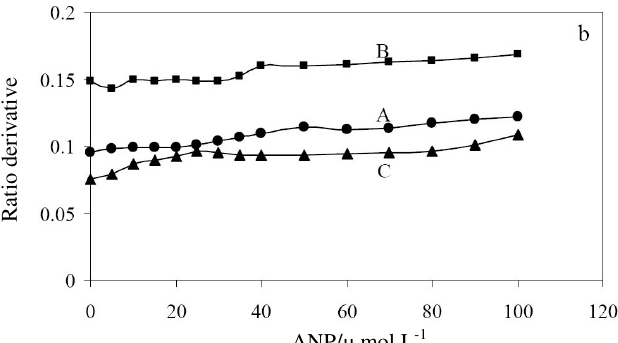
Figure 6. (a) Effect of concentrations of antazoline over the signals to analytical wavelength of 10.0 µmol L -1 naphazoline at different ∆λ values. (A) ∆λ = 2.0 nm; (B) ∆λ = 3.0 nm; (C) ∆λ = 5.0 nm. (b) Effect of concentrations of naphazoline over the signals to analytical wavelength of 30.0 µ mol L -1 antazoline at different ∆λ values. (A) ∆λ = 2.0 nm; (B) ∆λ = 3.0 nm; (C) ∆λ = 5.0 nm